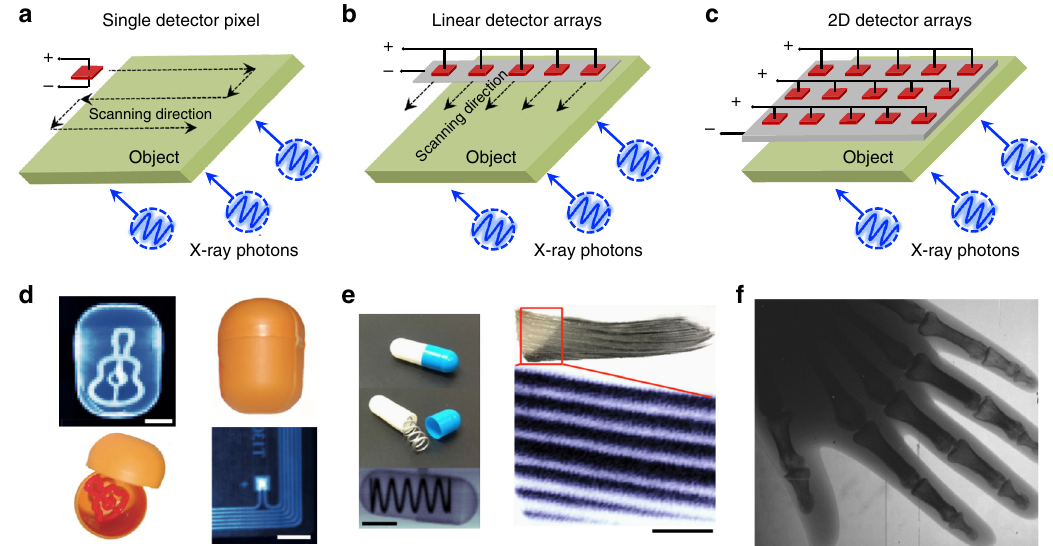
Fig. 3 X-ray imaging by single pixel, linear arrays, and two-dimensional (2D) arrays scanning. a – c Scheme of three different X-ray imaging processes: a single pixel scanning, b linear detector array (LDA) scanning, c 2D detector arrays scanning. d Optical and X-ray images of a plastic toy and an electronic key card. e Optical and X-ray images of an encapsulated metallic spring as well as a portion of a fi sh caudal fi n (top, right) and X-ray image of a section of it (bottom, right). f A hand phantom X-ray image obtained from a muon piston calorimeter (MPC) detector (using 100kVp and 5mGy air s − 1 for 5 ms exposure, resulting in a dose of 25 μ Gy air and a bias voltage of 50 V). Scale bars in d are 10 mm and the ones in e are 5 mm. d (ref. 17 ), e (ref. 66 ), and f (ref. 64 ) are all adapted with permission from Springer